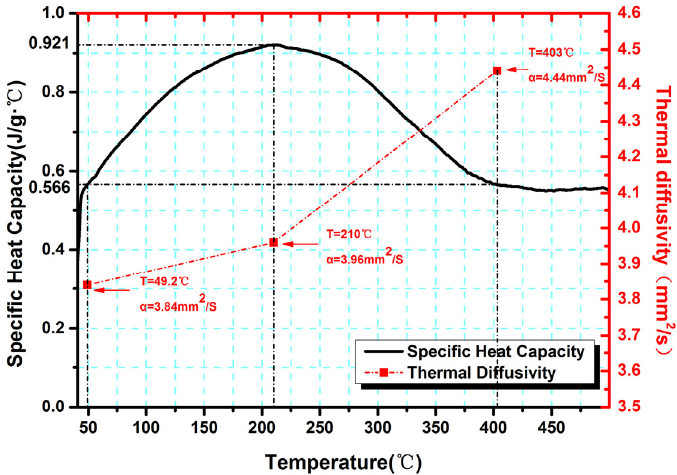
Figure 5. The specific heat of Cr 13 Ni 5 Si 2 -based composite coatings and the thermal diffusivity at 50 °C, 210 °C and 400